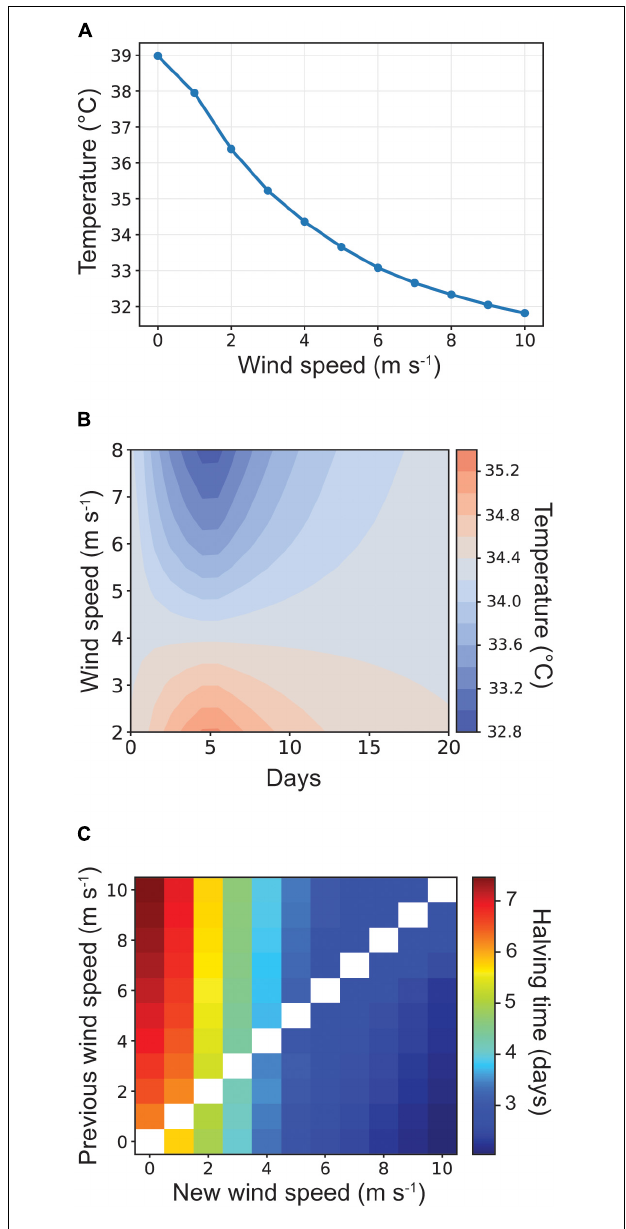
FIGURE 7 | Simulated influence of wind on sea-bottom temperatures under a constant meteorological and tidal forcing scenario. (A) Equilibrium bottom temperatures that will occur if winds persisted at a given speed. (B) Changes in bottom temperature as a result of a 5-day wind event at various speeds. Initial conditions set at 4 m s - 1 (which relates to bleaching threshold temperatures) with winds returning to initial conditions after the 5-day period. (C) The half time number of days it will take temperatures to reach a new equilibrium based on a given starting and ending wind